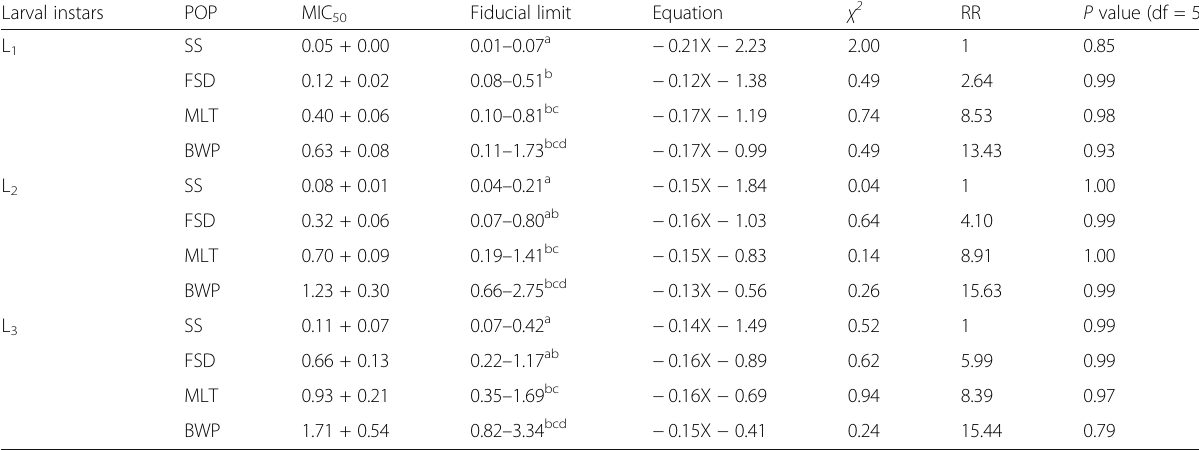
Table 4 Molt inhibitory concentration of susceptible and field population of Spodoptera exigua to Cry1Ac toxin during